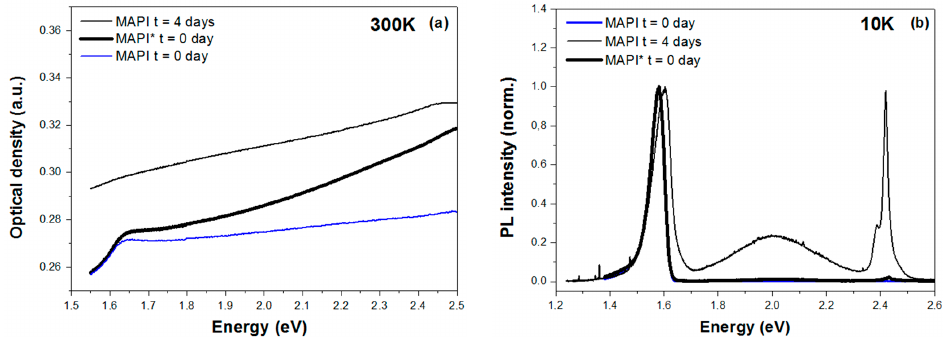
Figure 4 . Cont . Figure 4. Cont